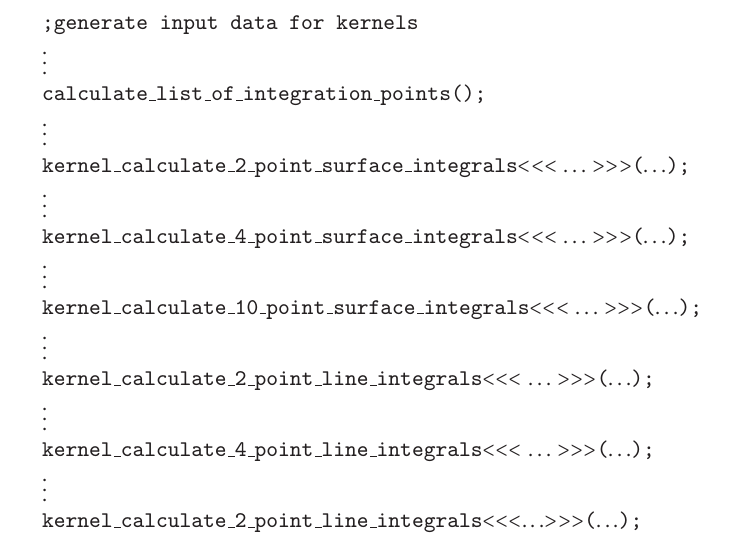
Algorithm 2: Pseudocode of the submatrix